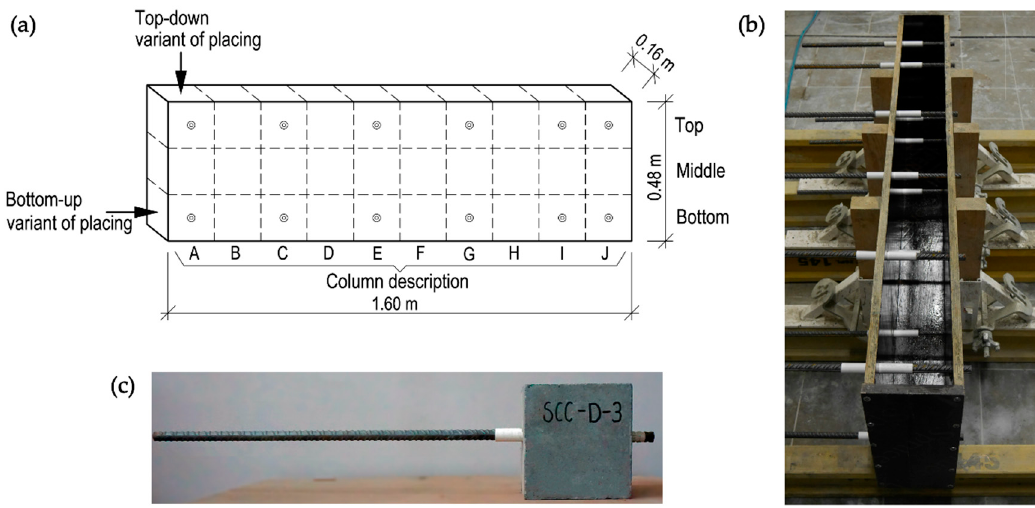
Figure 2. The specimens used in the research: ( a ) schematic view of the element; ( b ) photograph of the formwork used; ( c ) basic model for pull-out test.